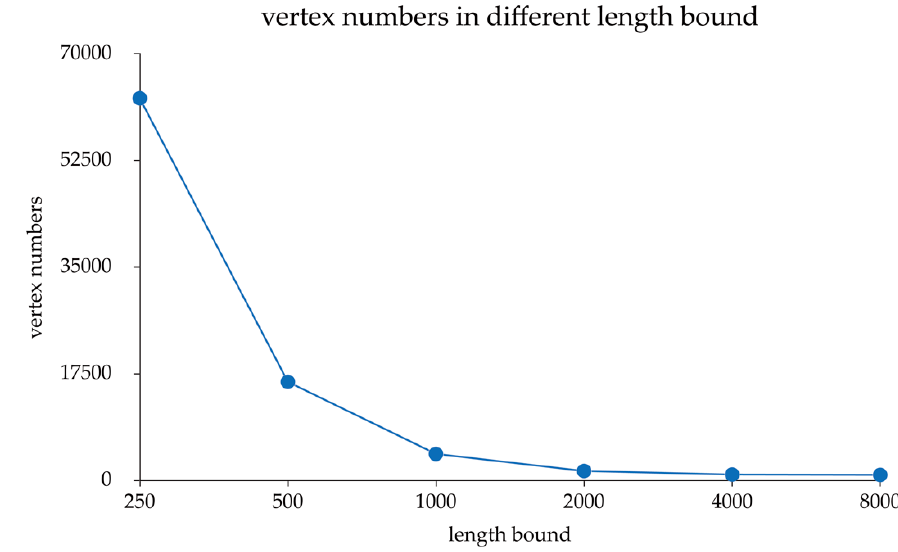
Figure 5. Vertex numbers in different length bound.